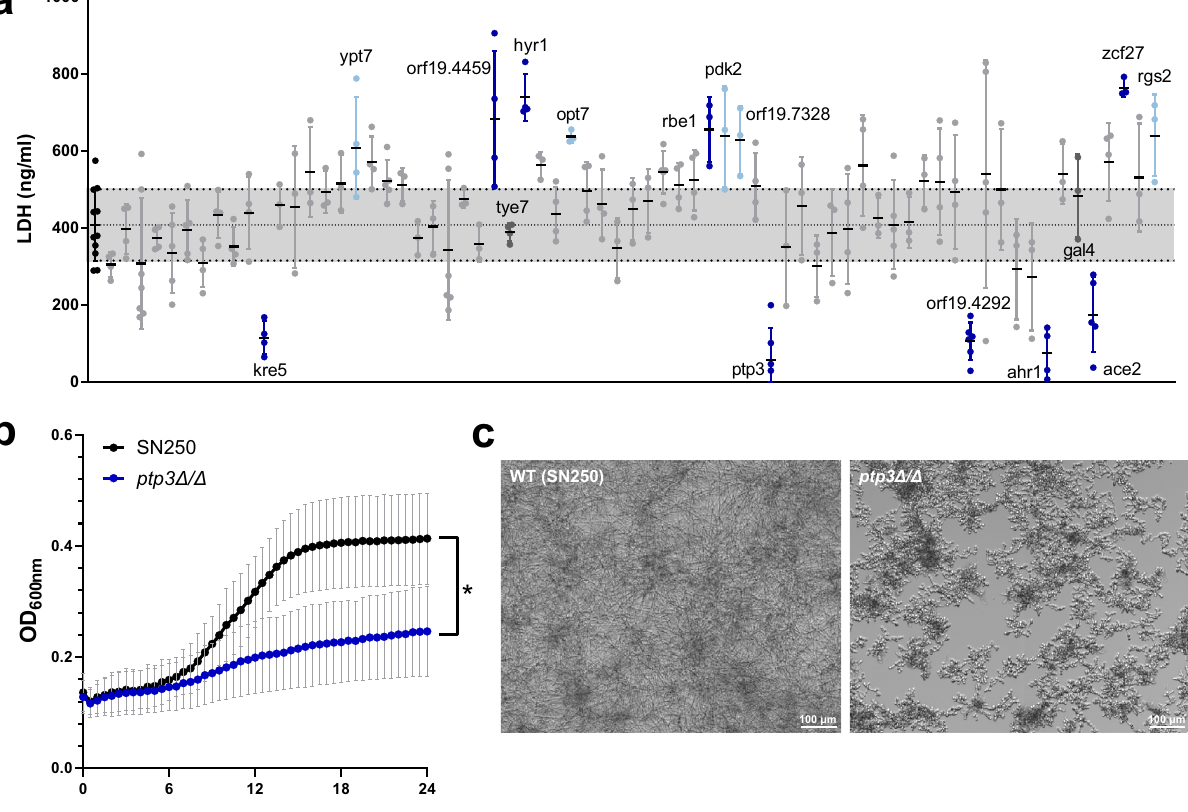
Fig. 7 Screening of C. albicans deletion mutants. a Ability of deletion mutants to induce necrotic cell damage of IECs assessed by LDH activity in the supernatant at 24 hpi. Data are shown as the mean and standard deviation (SD) with dots showing the individual replicates ( n = 3 – 11 biological replicates). Deletion mutants were compared to the wild-type control using a one-way ANOVA and Dunnett ’ s Multiple Comparison post-hoc analysis. Mutants with a signi fi cantly increased or decreased damage potential (dark blue, p -value ≤ 0.05; light blue, p -value ≤ 0.1) are labelled (see Supplementary Table 4 for exact p- values). Horizontal lines correspond to the mean of the damage induced by the wild-type ± SD. b Growth rates of the ptp3 Δ / Δ mutant with signi fi cantly reduced growth (blue line) compared to the parental strain (black line) in KBM. Lines represent the mean and SD of n = 3 independent experiments and were compared for signi fi cance using a two-way Repeated Measures ANOVA, * = p 0.0188. Source data are provided as a Source Data fi le. c Representative images of the ptp3 Δ / Δ deletion mutant and the parental strain morphologies, after 24 h incubation in KBM at 37 °C with 5% CO